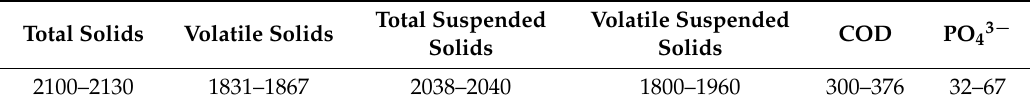
Table 1. Main characteristics of the sewage sludge (mg/dm 3 ) before treatment.